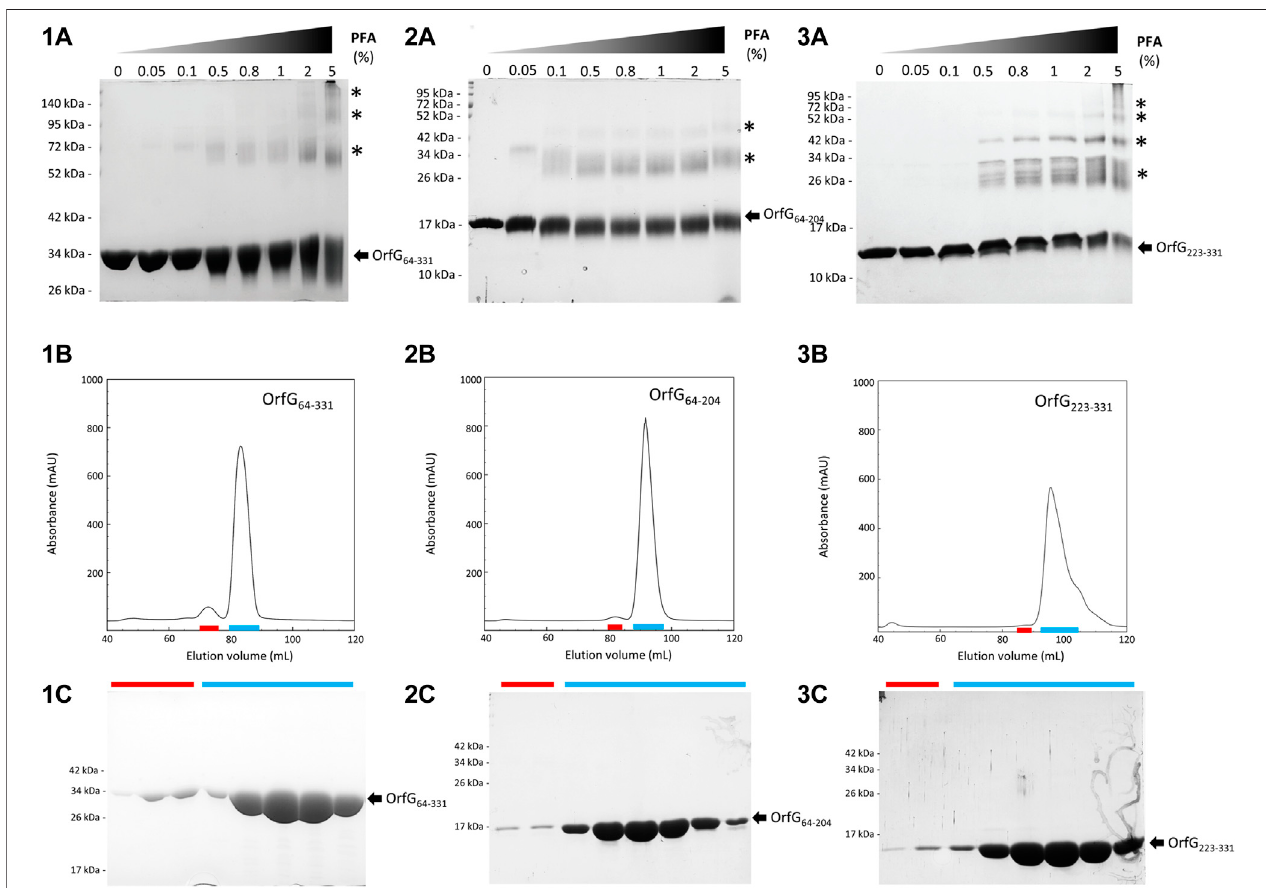
FIGURE7| Analysis ofoligomerization ofnative and truncated versions ofOrfG 64 – 331 by in vitro chemical cross-linking and sizeexclusion chromatography. Invitro chemical cross-linking of OrfG 64 – 331 ( 1A ), OrfG 64 – 204 ( 2A ) and OrfG 223 – 331 ( 3A ). SDS-PAGE analysis of 3 µM of the puri fi ed OrfG 64 – 331 and its truncated versions in absenceorinpresenceofanincreasingconcentration(0.05 – 5%)ofparaformaldehyde(PFA).Sampleswereloadedwithoutheatingtreatment.TheconcentrationofPFA used for each reaction is mentioned at the top of each column. Asterisks indicate the identi fi ed oligomers stabilized by PFA cross-linking. Size exclusion chromatography (SEC) of the puri fi ed OrfG 64 – 331 ( 1B ), OrfG 64 – 204 ( 2B ) and OrfG 223 – 331 ( 3B ) using Superdex 200 16/600. The elution volume (ml) is plotted on the x -axis and the 280-nm absorbance is plotted on the y -axis. SDS-PAGE analysis of SEC puri fi cation of OrfG 64 – 331 ( 1C ), OrfG 64 – 204 ( 2C ) and OrfG 223 – 331 ( 3C ). Red and green lines correspond to the SEC fractions selected from each peak and analyzed by SDS-PAGE. Electrophoretic separation shows that all identi fi ed peaks contain exclusivelytheanalyzedprotein.Molecularweightmarkers(inkDa)areindicatedontheleftofeachSDS-PAGEpattern.Proteinbandscorrespondingtoeachproteinare indicated by black